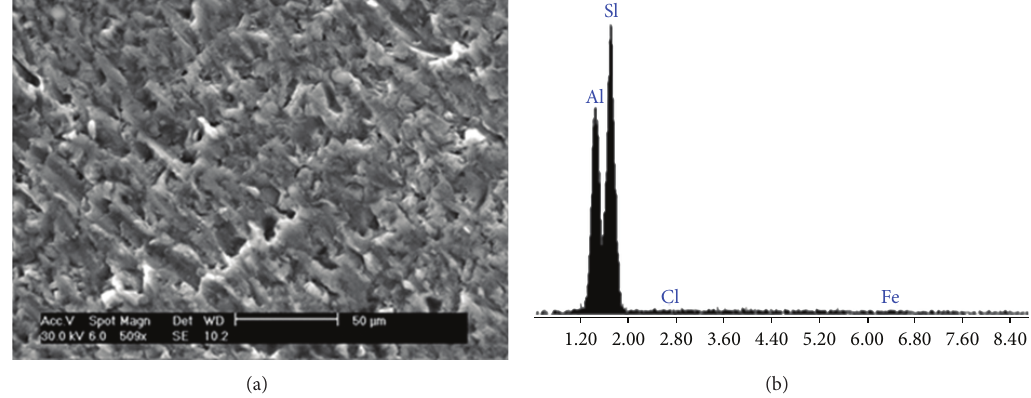
Figure 1: SEM micrograph and EDX 20 wt.% red mud casted composite.